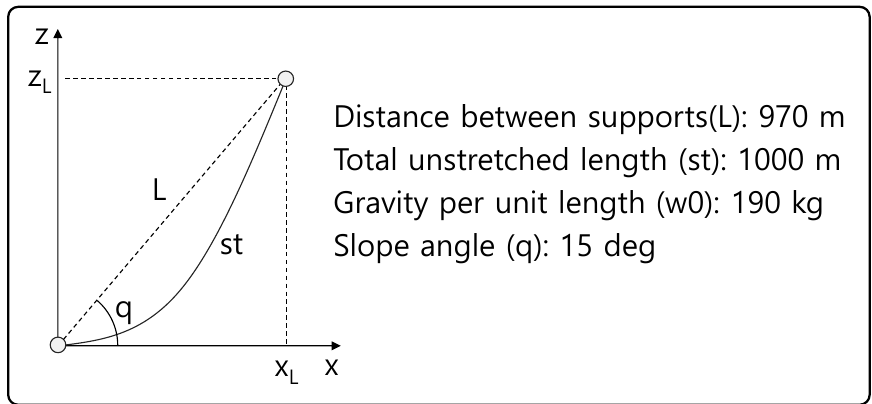
Figure 3. Numerical example of mooring line.